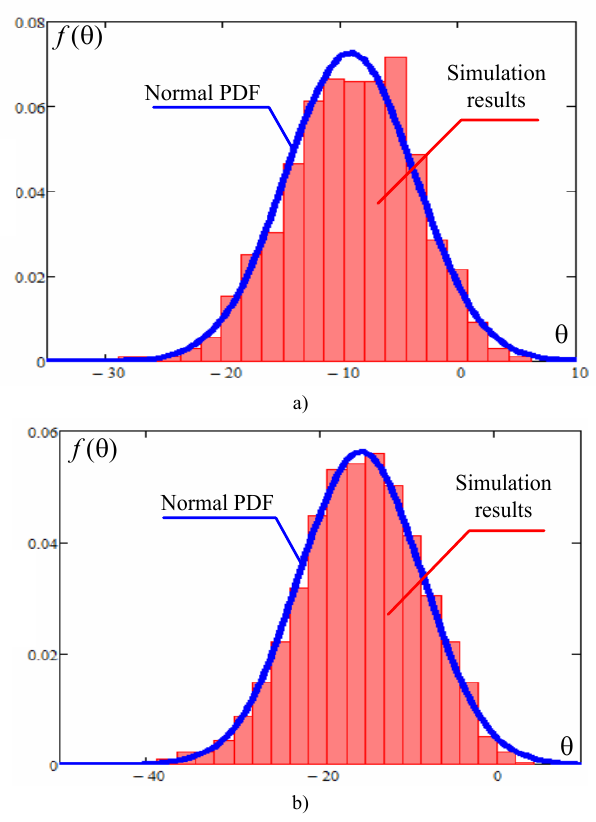
Fig. 4. The results of simulation. According to Bellman’s approach [24] the thresholds values are calculated from the last point of decisive statistic (sample number N ) to the first (sample number N ). At the last point tr st to determine the threshold, it is necessary to use equation (4). In α this case, we need to provide the given level of probability 0 of the first kind error. At the previous step, the threshold value and the probability of procedure stopping during M failure occurrence. The next thresholds are calculated